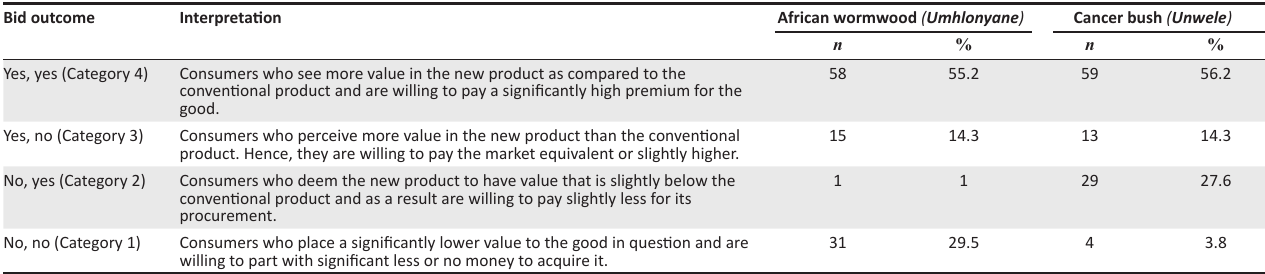
TABLE 3: Distribution of bid outcomes. Bid outcome